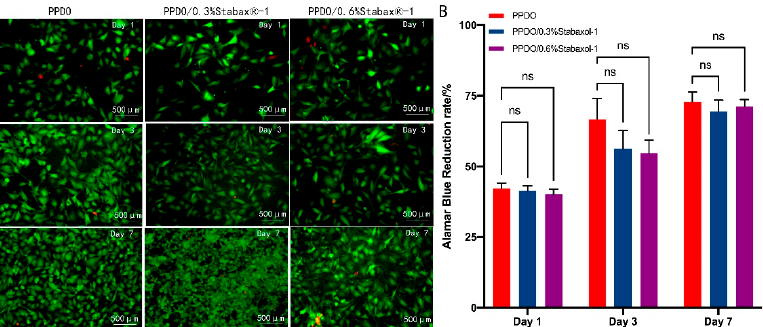
Figure 7. Cytocompatibility of HUVECs on the different BRS groups. ( A ) Merged fluorescent images with live cells stained in green and dead cells stained in red, indicating the viability of HUVECs on PPDO, PPDO/0.3% stabaxol ® -1, and PPDO/0.6% stabaxol ® -1 BRSs at various time intervals (1, 3, 7 days). ( B ) Viability of HUVECs cultured on BRSs with different weights of stabaxol ® -1 after different cell culture time periods.